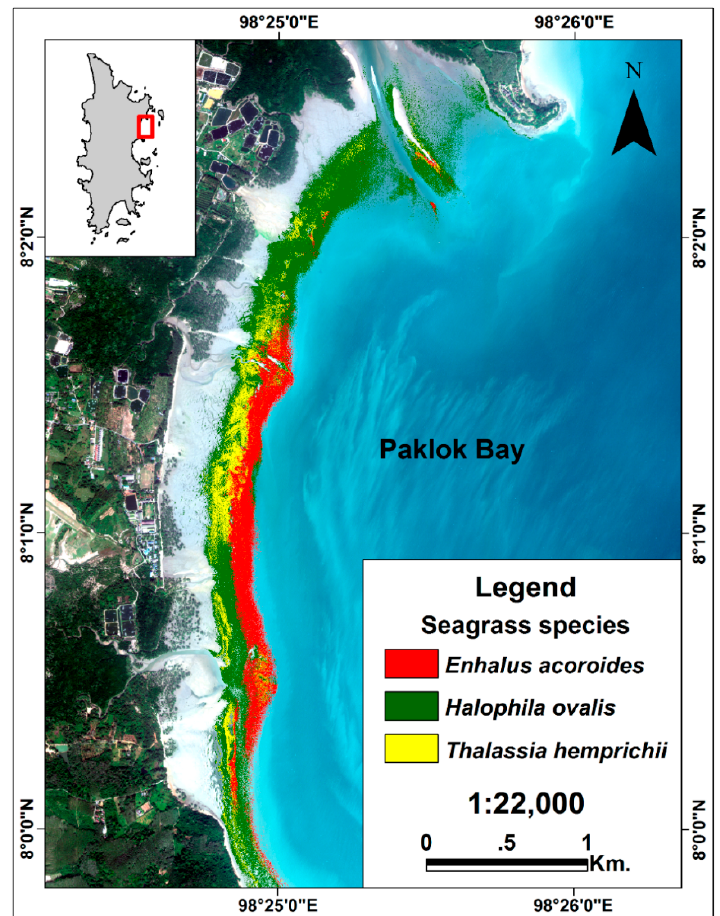
Figure 4. The dominant seagrass species map for Paklok Bay derived from Worldview-2 image and field reference data.